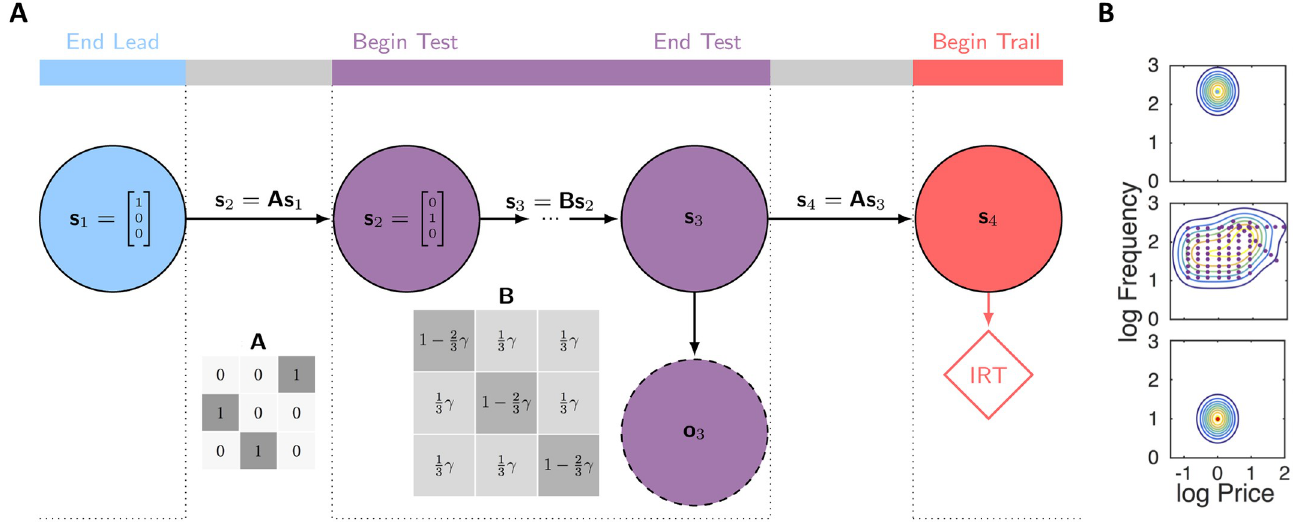
Fig 5. Modelling the inference process. ( A ) We characterise subjects as building an HMM generative model of the task and performing recognition to produce posterior subjective beliefs over the trial types. In our model, at the end of a lead trial the subject is certain it is on a lead trial ( s 1 ). As it has learned the transition structure, described by matrix A , it is therefore certain it is on a test trial at the beginning of a test trial ( s 2 ). If recognition was perfect, this knowledge would persist through the test trial; we model subjects’ imperfection as arising from uncertainty in past evidence, which we describe using a parameter γ , which parameterises the matrix B . By the end of the test trial, past evidence is integrated with the within-trial evidence provided by observations ( o 3 ) of frequency and price. This leads to a posterior belief ( s 3 ), which then leads to the subjective belief about the trial type at the beginning of what is actually the trail trial ( s 4 ). This can then be used to generate a response: either no engagement or engagement with an associated IRT. ( B ) We describe the association between observations in frequency-price space and trial type using a mixture of Gaussians centered at the experimentally utilised points for lead (top), test (middle) and trail (bottom) trials. We introduce a standard deviation parameter ( σ ) which is shared across all points.